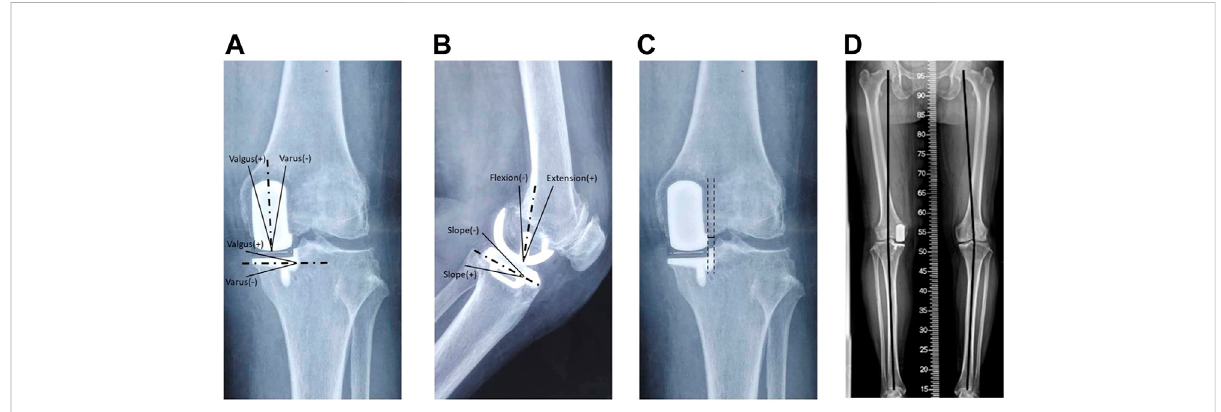
FIGURE 4 Radiological measures of the prosthesis after UKA. (A) Valgus/varus angle of femoral and tibial components on the antero-posterior view; (B) fl exion/extensionangleofthefemoralcomponentandslopeofthetibialcomponent; (C) adjacentdegreebetweenfemoralandtibialcomponents,a line is drawn vertical to the ground from the lateral edge of the femoral component, and the adjacent degree is measured as the horizontal distance between this line and the tibial vertical osteotomy line; (D) hip – knee – ankle angle (HKAA).